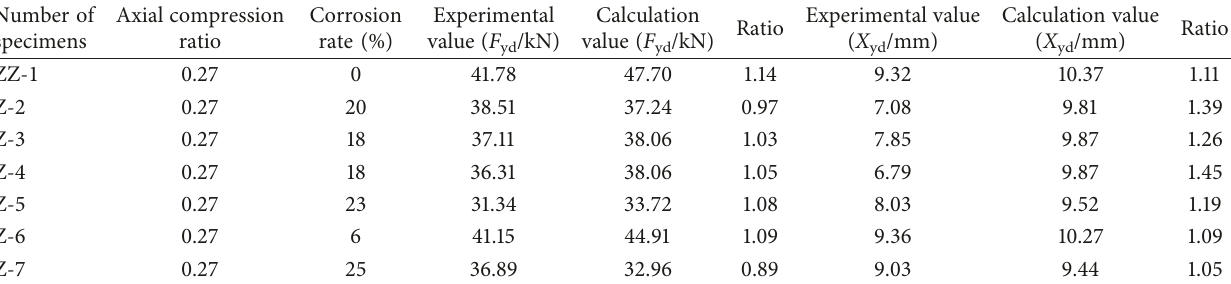
Table 3: The comparison between theoretical value and experimental value.